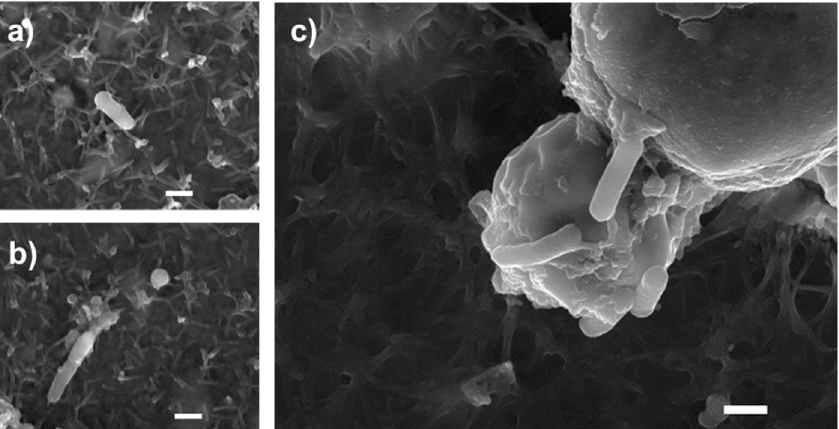
Figure 3. Bacterial agglutination capacity of tiger nut. SEM images of cultures incubated for 3 h ( a ) and ( b ) in the presence of S . enteritidis (MOI 10), and ( c ) in the presence S . enteritidis (MOI 10) in addition to tiger nut (2.5 mg/mL). Representative results were reproduced in three separate experiments. The white bar represents 1 μ m.